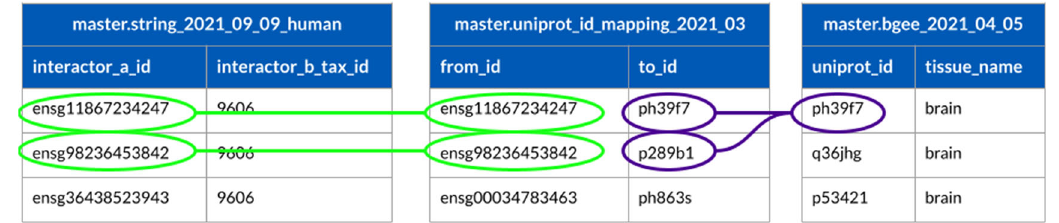
Figure 8. This schematics describing the mapping between identifiers of two tables in the master zone ( ‘ string_2021_09_09_human ’ , which contains the human interactions from the STRING database, ‘ uniprot_id_mapping_2021_03 ’ , which contains the mapping information between different types of identi- fiers and ‘ bgee_2021_04_05 ’ , which contains the tissue information of the